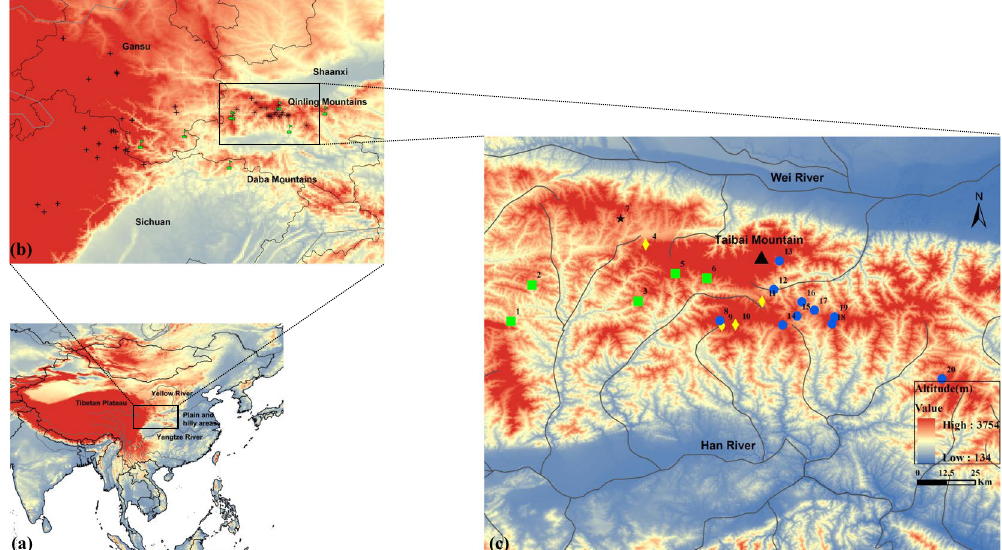
Figure 1. Geographical distribution of B . tibetanus in China and sampling locations in the Qinling Mountains used in this study. ( a ) Geographical distribution of B . tibetanus across its main distribution range in China. ( b ) Distribution of the Tibet and eastern lineages of B . tibetanus . The Tibet lineage of B . tibetanus is labelled by cross including 24 locations from prior study 25 and the QLC population of this study, and the eastern lineage is labelled by school (8 locations from prior study) and asterisk (19 of 20 sampling locations of this study). The eastern lineage of B . tibetanus is previously described as B . taibaiensis 35 . ( c ) Sampling locations in the Qinling Mountains used in this study. The two major population lineages are labelled by green squares and blue circles, respectively. The yellow diamonds indicate populations possessing haplotypes from both lineages. The QLC population is labelled by a black star. The numbers indicate different populations (see Table 1). The optimal number of population groups is three revealed by the Spatial Analysis of Molecular Variance (SAMOVA). The western group consists of the population 1–6, the eastern group contains the population 8–20, and the third group contains only the QLC population. The main rivers in the distribution area are shown by lines, and the Taibai Mountain (3767 m) is labelled by a black triangle. The map was generated using ArcGIS 9.3 (http://www.esri.com/software/arcgis) and Adobe Illustrator CS4 v14.0.0 (Adobe Systems Inc., San Francisco, CA). The Digital Elevation Model (DEM) for Fig. 1c was downloaded from the website, which was provided by Data Center for Resources and Environmental Sciences, Chinese Academy of Sciences (RESDC)